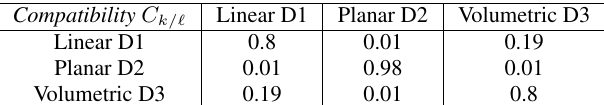
Table 1: Compatibility Matrix